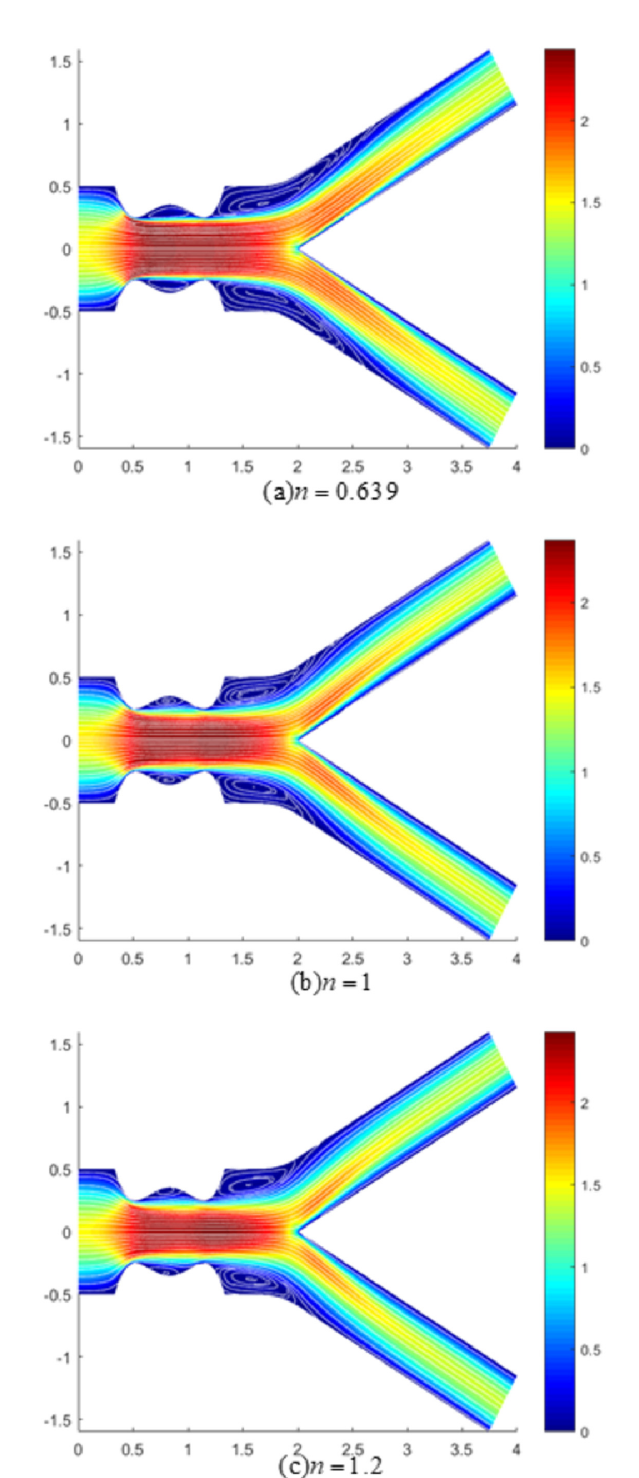
Fig 13. Velocity contour with streamlines pattern for (a) n = 0.639 (shear-thinning), (b) n = 1 (Newtonian) and (c) n = 1.2 (shear-thickening) fluids ( M = 12, Re = 300 and τ m = 0.4 a ).